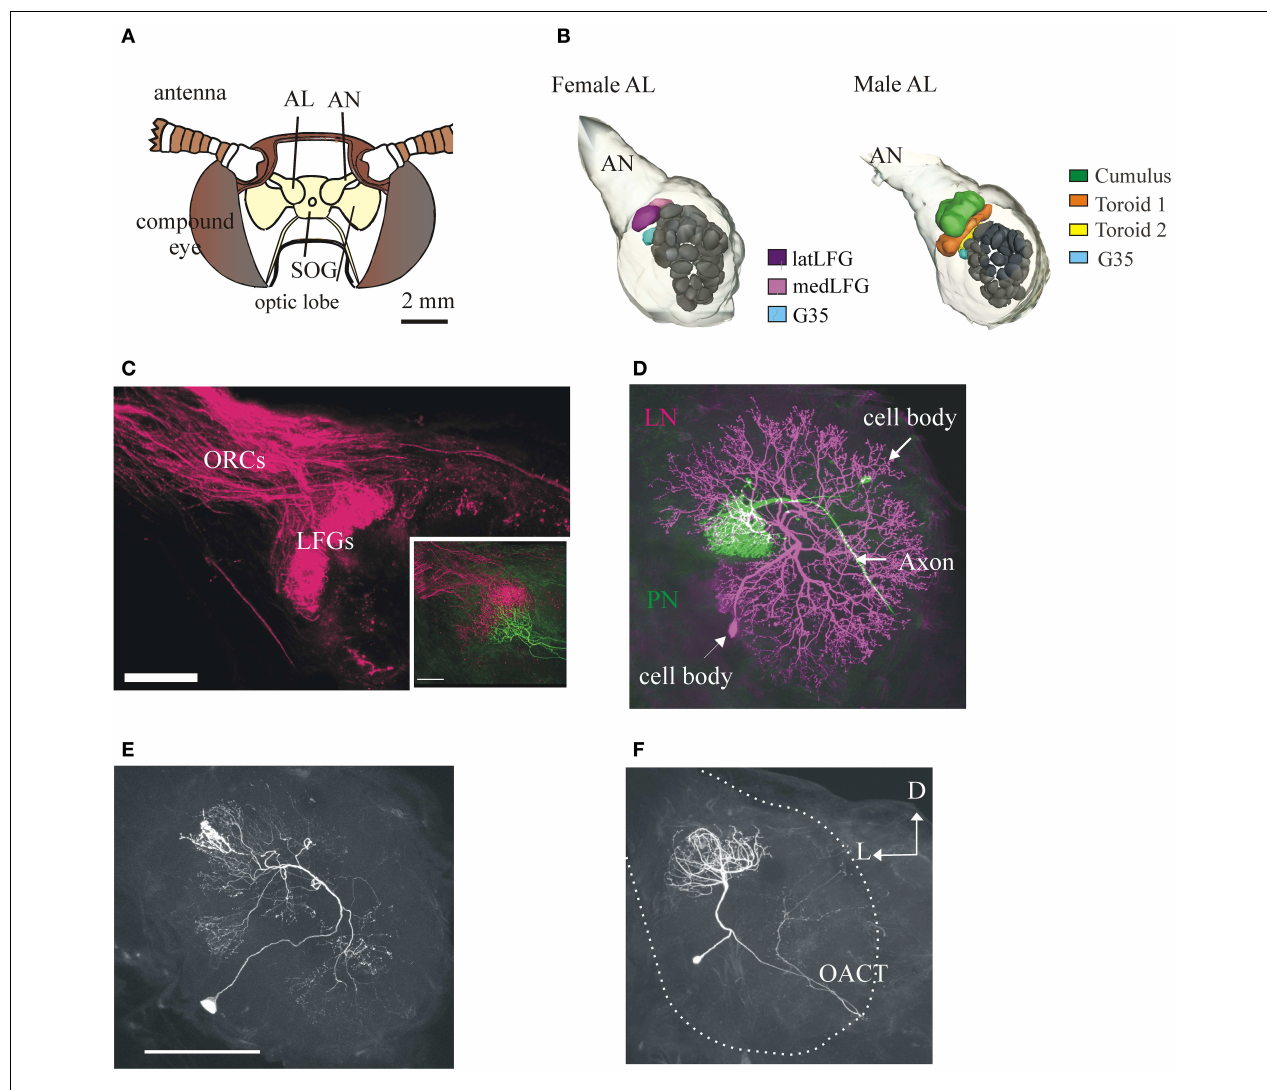
FIGURE 2 | Anatomy of the primary olfactory center of the moth M. sexta and its neuronal components. (A) Schematic frontal view of the moth’s head. Each antennal lobe (AL) receives input from antennal olfactory sensory neurons (OSNs) through the antennal nerve (AN) (one glomerulus receives input from the labial palps, not shown). SOG, suboesophageal ganglion. (B) 3-D reconstructions of the M. sexta ALs from a female (left) and a male (right), showing the sexually dimorphic glomeruli (LFGs in females, the Cumulus and the two Toroids in males) and a sexually isomorphic glomerulus (G35, in light blue) of known odor input. Scale bar: 50 µ m. (C) Confocal image showing OSN afferent input to the LFGs. Inset: mass-labeled OSNs with a single-labeledLFGprojectionneuron(ingreen).Scalebar:100 µ m.Figurewith permission from Dr. J. Hildebrand. (D) A female AL showing the two main